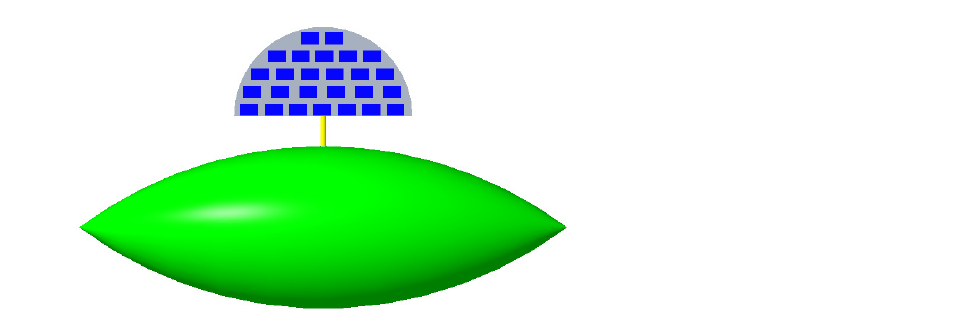
Figure 9. Three-dimensional model of the satellite after the deployment of the fan-shaped solar array. In order to study the RCS variation in the satellite before and after the sector solar array deployment, the schematic of the incident wave after the solar array deployment and the RCS comparison before and after the satellite solar array deployment are given in Figures 10 and 11, respectively, with an incidence frequency of 4 GHz, VV polarization, and circumferential incidence.